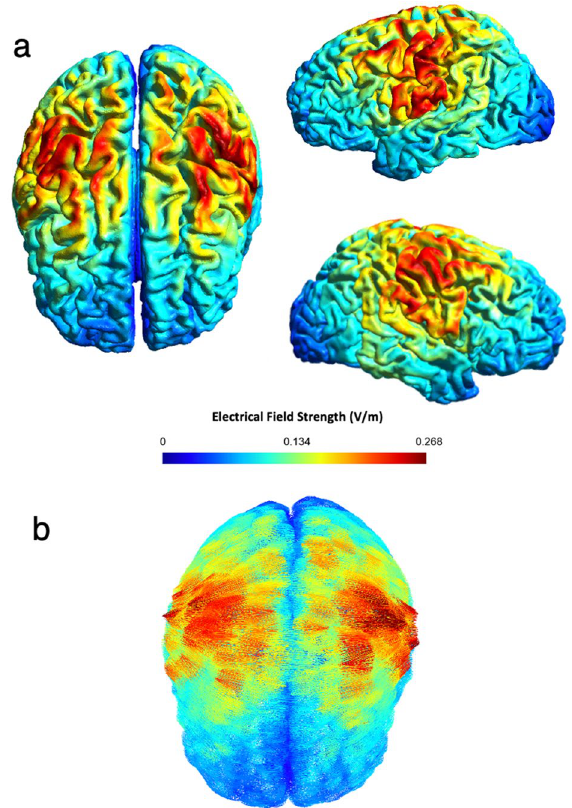
Figure 3. Electrical field model. ( a ) Normal component of the electrical field (electrical field strength in V/m) and its neuroanatomical distribution. ( b ) Representation of the electrical field vectors for the same model